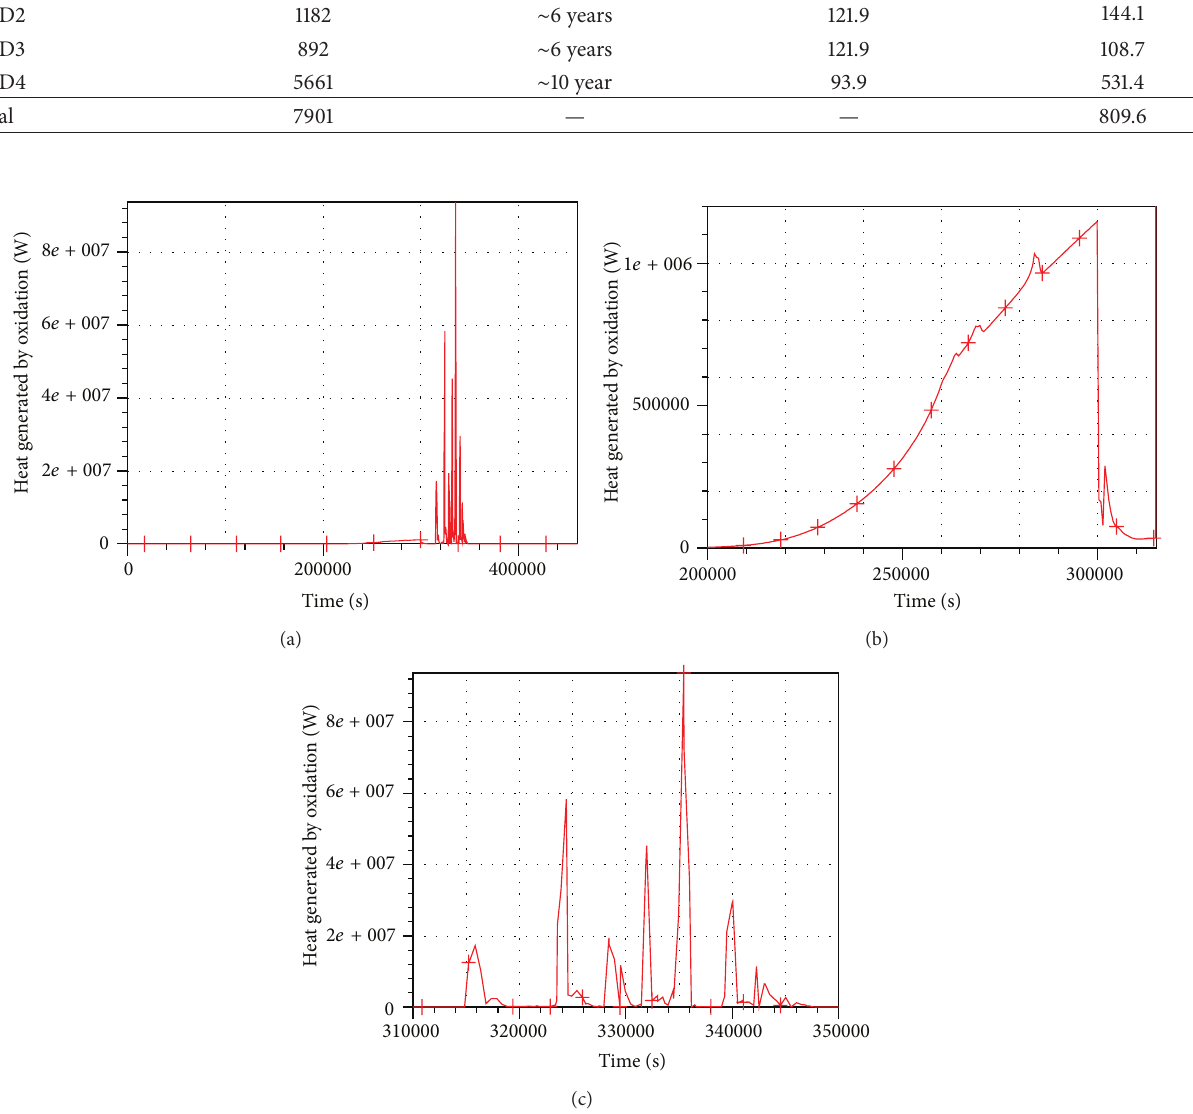
Figure 7: Heat generated by oxidation: (a) heat generation due to fuel cladding oxidation in air and steam during whole period of accident, (b) slow heat generation due to fuel cladding oxidation at temperature below 1200 ∘ C heat generation due to intensive fuel cladding oxidation in steam at temperature higher than 1200 ∘